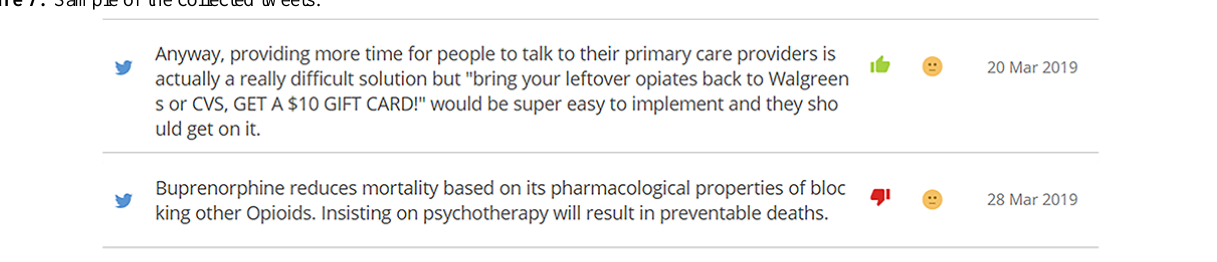
Figure 7. Sample of the collected